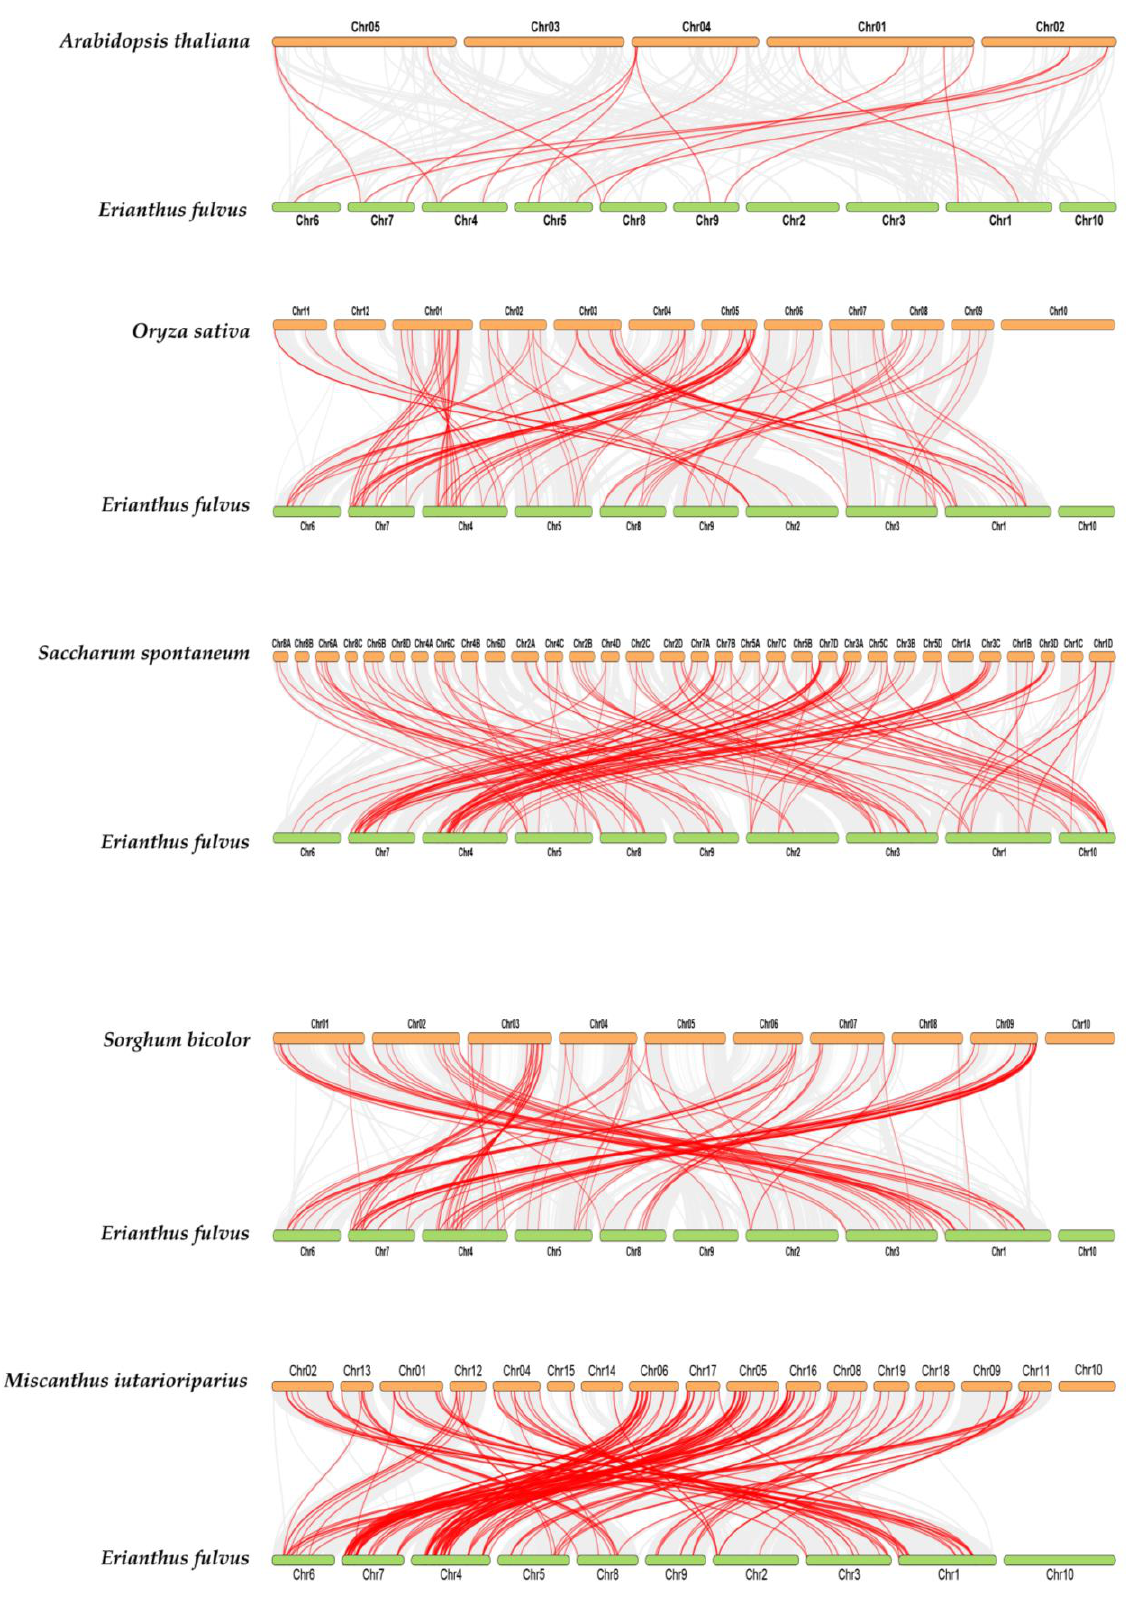
Figure 6. Synteny analysis of WRKY family. A. thaliana , S. bicolor , M. iutarioriparius , E. fulvus , O. sativa , and S. spontaneum . Red lines are the syntenic WRKY gene pairs. Gray lines are collinear blocks.